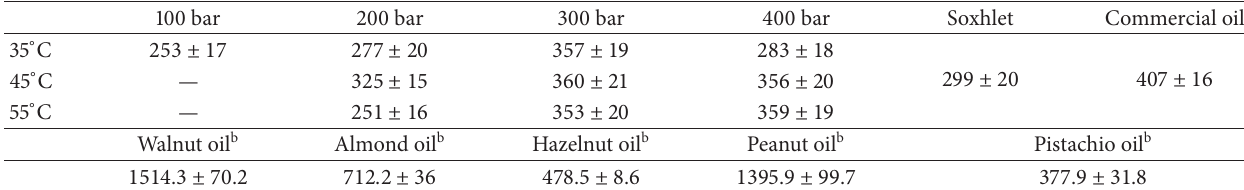
values, mg/mg DPPH). 50